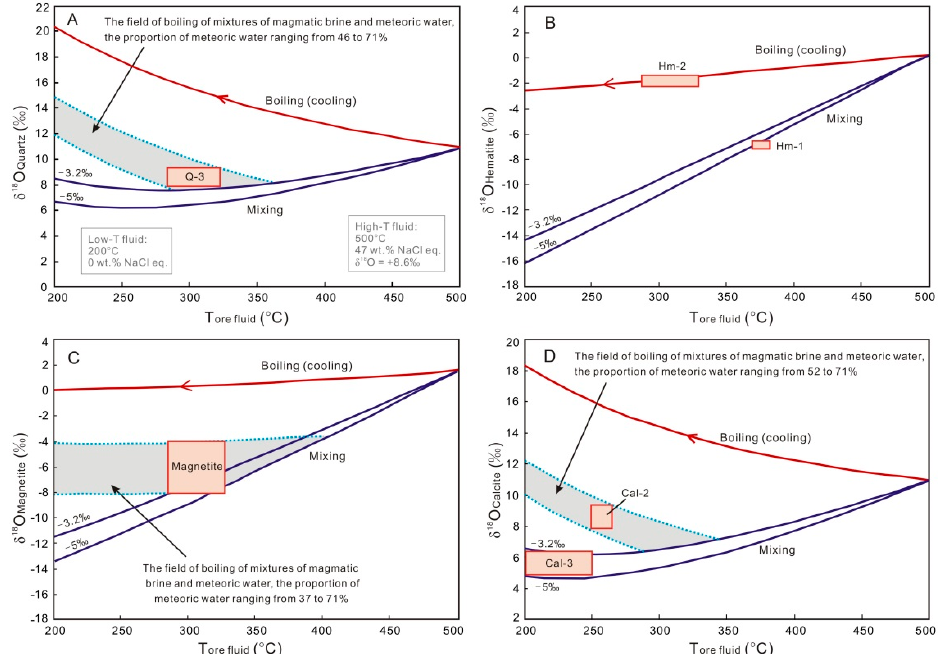
Figure 5. Diagrams showing the effects of boiling (cooling), mixing of magmatic and meteoric water, and the cooling of boiling mixtures of fluids derived from magmatic and meteoric water on the oxygen isotope compositions of quartz ( A ), hematite ( B ), magnetite ( C ), and calcite ( D ). The starting conditions for the magmatic water were a temperature of 500 °C, a salinity of 47 wt.% NaCl equiv., and a δ 18 O value of 8.6 ‰. Mixing lines were calculated assuming that the groundwater had a temperature of 200 °C, zero salinity, and δ 18 O values of –5.0‰ and –3.2‰ (labels on the mixing lines). The mixing proportions between magmatic and meteoric were derived based on the binary mixing model (R M = R A × ω A + R B × ω B , ω A + ω B = 1, where R M, R A , and R B represent the mixing value and end-number A and B values, respectively; ω A and ω B represent the mass fractions of A and B). Table 2. Calculated oxygen isotope compositions of quartz, hematite, magnetite, and calcite in the mixing model. F = mass δ 18 O mineral T mix ( °C ) δ 18 O water Fraction Brine Quartz Hematite Magnetite Calcite The Minerals in Equilibrium with A Magmatic Brine ( T = 500 °C, δ 18 O = 8.6‰) That Is Mixing with Meteoric Water ( T = 200°C, δ 18 O = − 3.2‰)